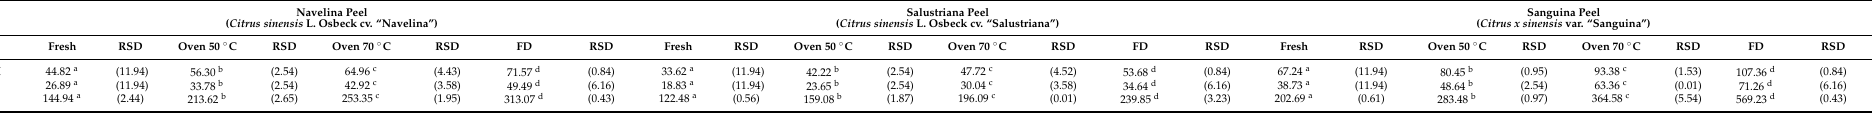
Table 5. Antioxidant activity (mg trolox · g − 1 DW) and relative standard deviations (RSD) for fresh and dried Navelina, Sanguina, and Salustriana orange